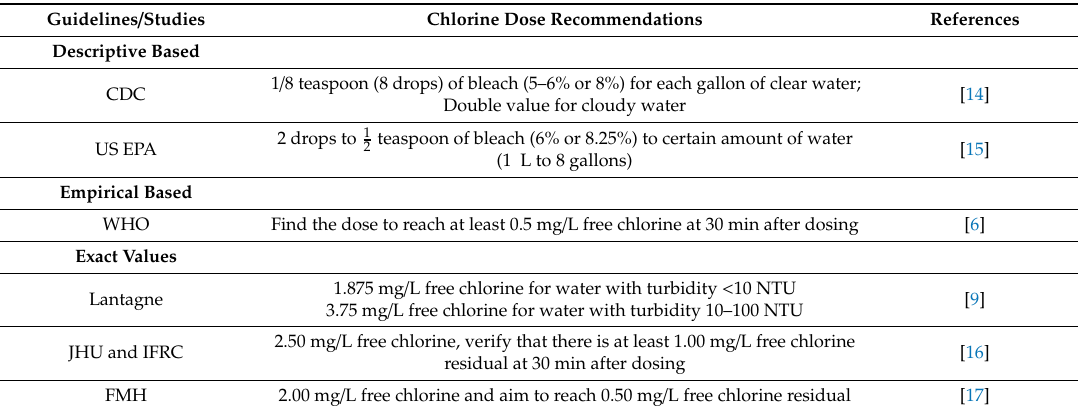
Table 1. Chlorine dosages recommendations from several guidelines and